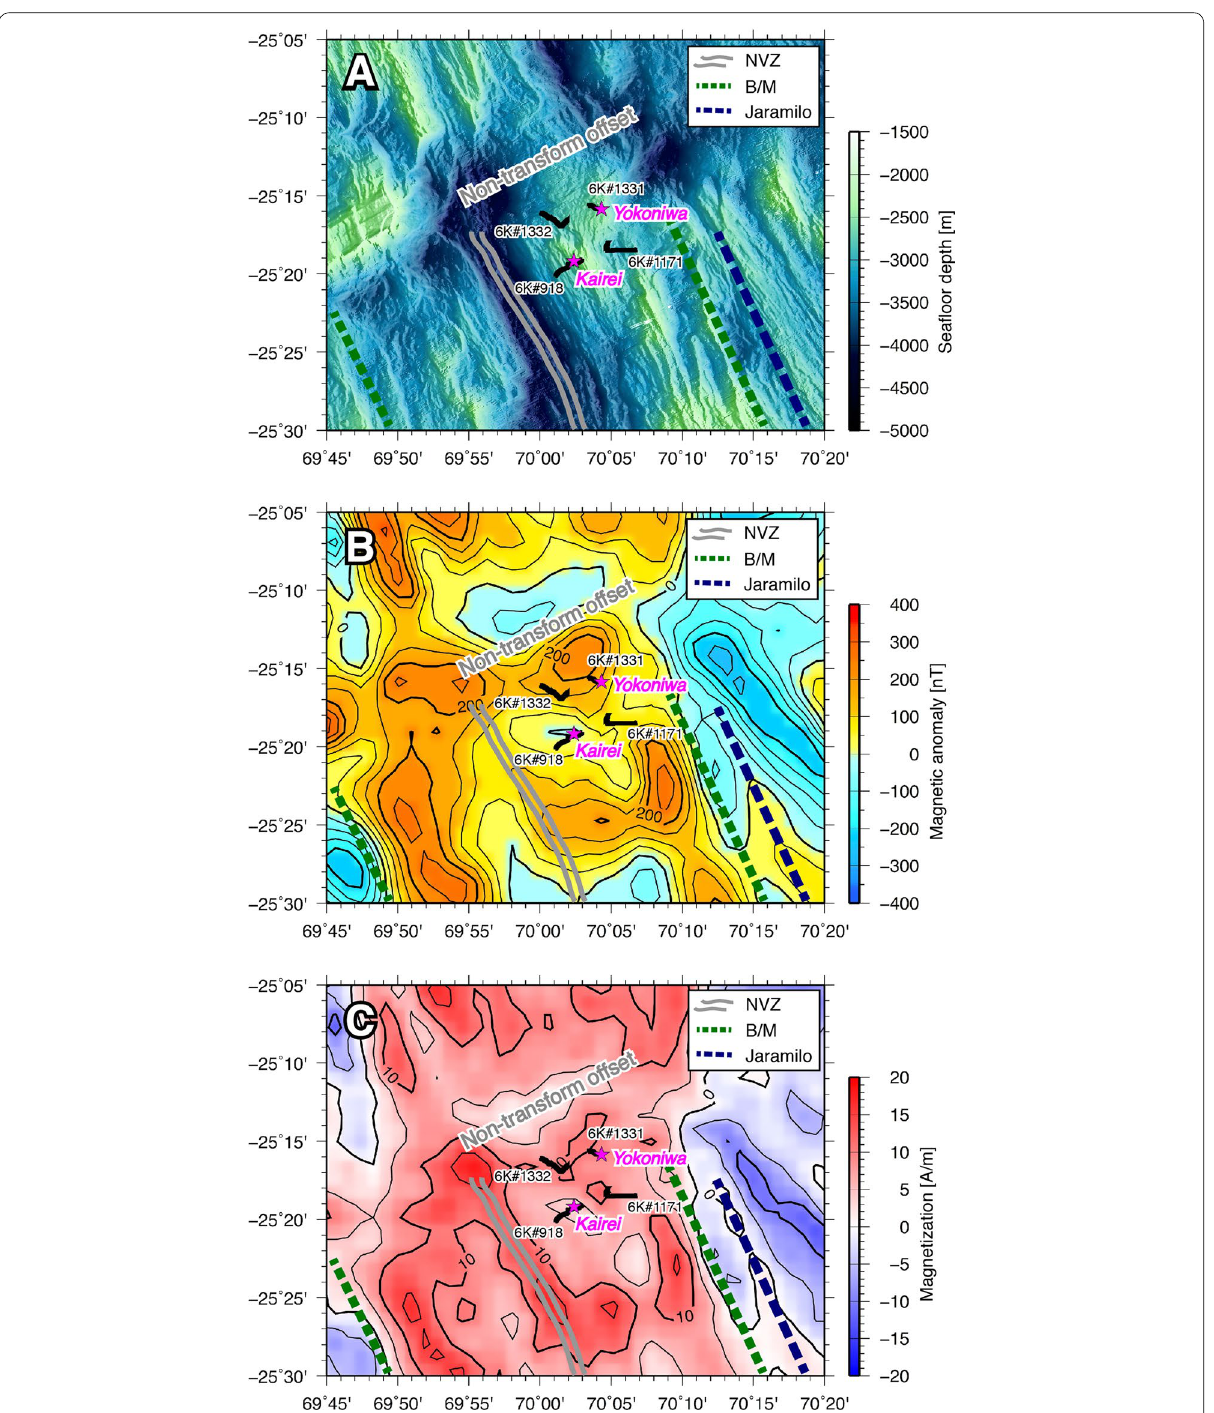
Fig. 2 Survey tracks to obtain studied near-seafloor magnetic anomalies near the Kairei and Yokoniwa hydrothermal fields of the Central Indian Ridge overlaying a bathymetry, b magnetic anomaly, and c magnetization distribution maps (modified from Okino et al. 2015). Dives 6K#918, 6K1171, and 6K#1332 were conducted in an off-axis area of segment-1 of the Central Indian Ridge. NVZ neo-volcanic zone, B/M: Brunhes–Matuyama boundary (0.78 Ma); Jaramilo: magnetic isochron of Jaramilo chron 1r.1 (0.99–1.07